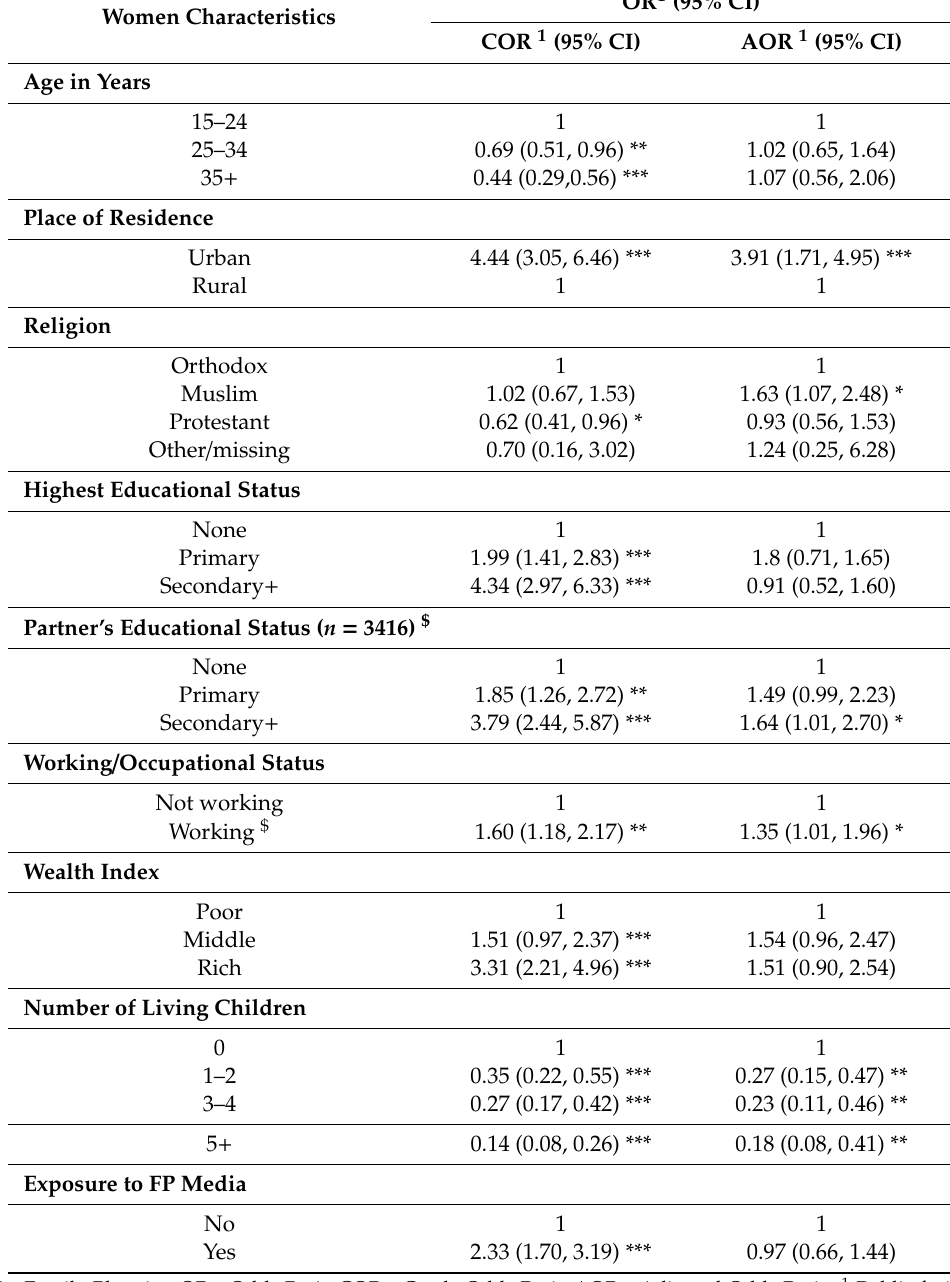
Table 3. Association of women’s characteristics with the types of health facility where they accessed FP services (private vs. public), EDHS 2016 ( n =